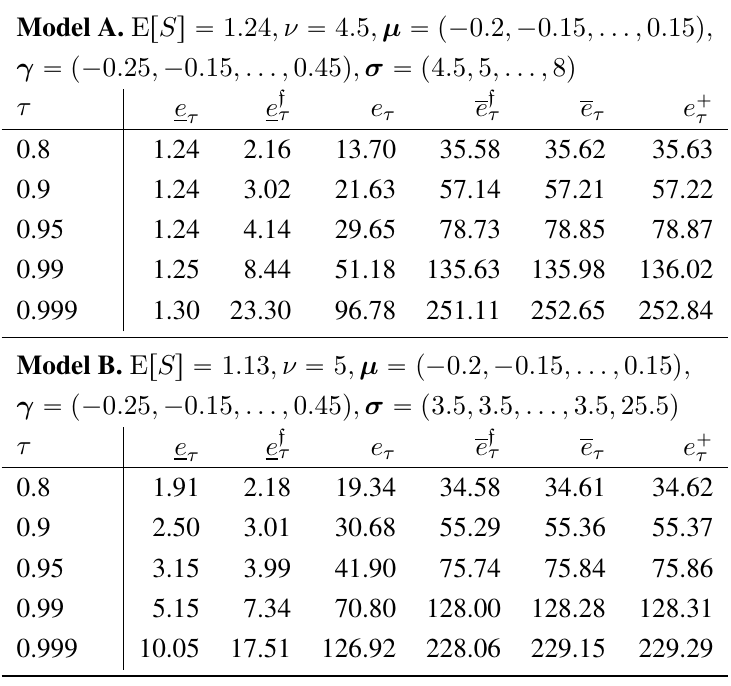
Table 2. Upper and lower dependence uncertainty (DU) bounds for e examples with d “ 8 . Column e diagonal Σ